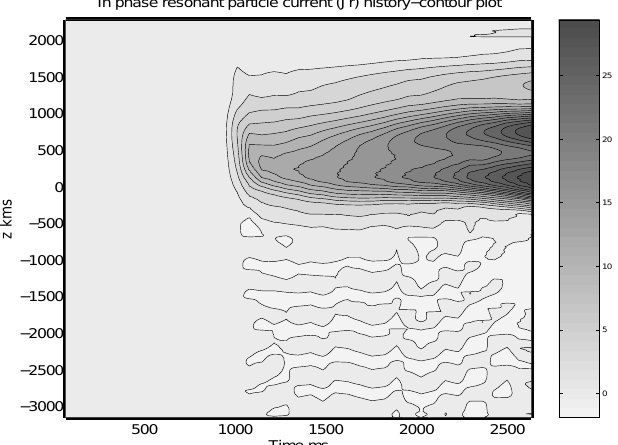
Fig. 11. Run 1. History of in phase current − J r in the simula- tion box, in units of J r (lin); this component gives nonlinear wave growth. The steady increase with time relates to the rising frequency of the emission, increasing resonant electron fluxes, and increasing growth rates.